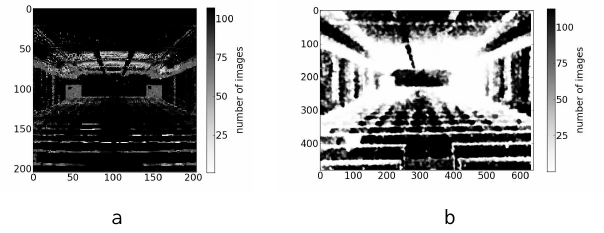
Figure 5. Number of available measurement values: a) PMD [vision] CamCube 2.0, b) Microsoft Kinect.